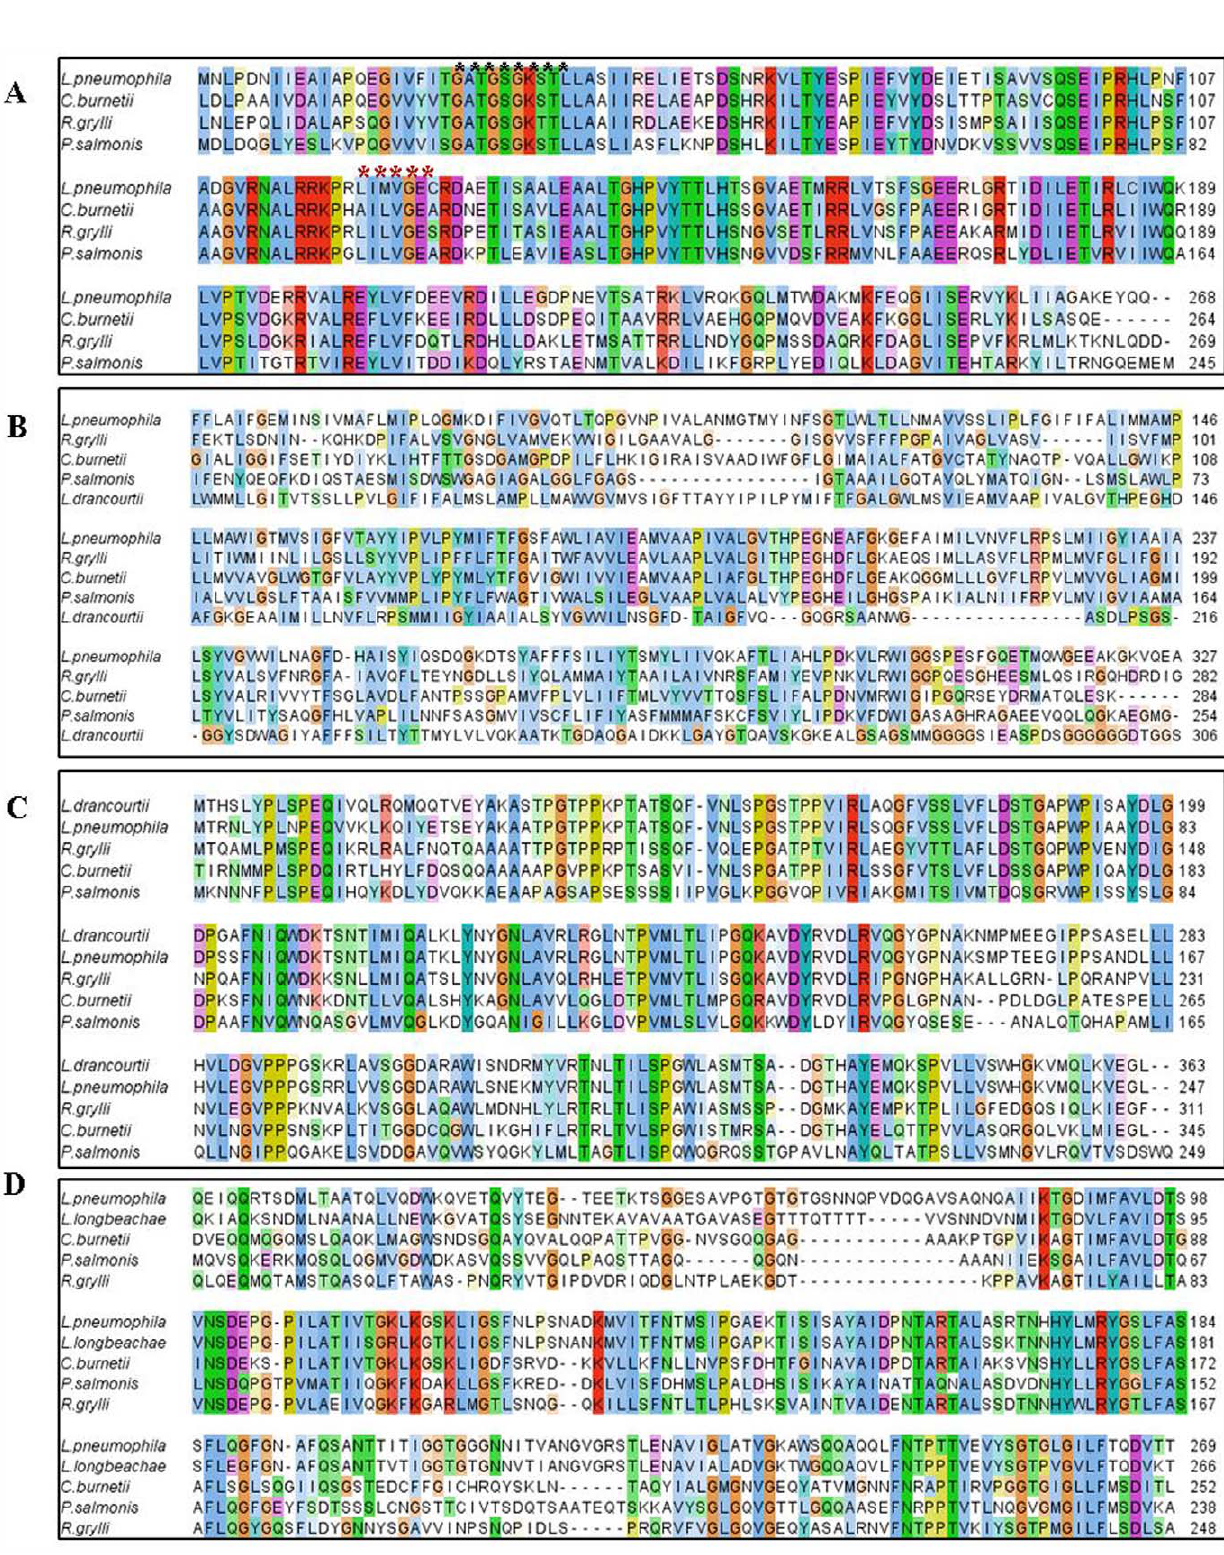
PLOS ONE | www.plosone.org